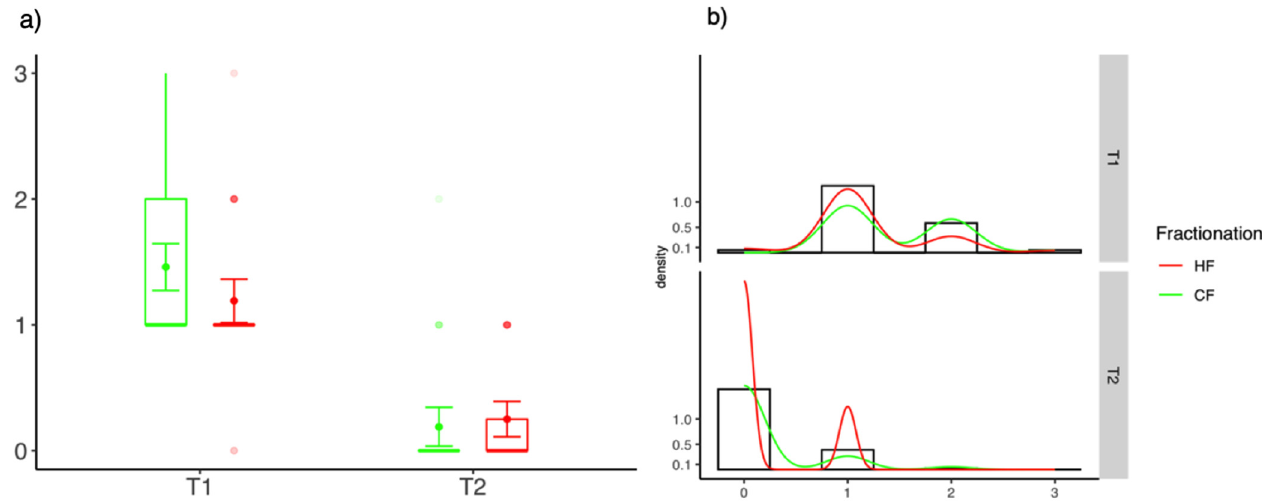
Figure 1. Differences of CTCAE scores between HF-WBI and CF-RT at the end of radiotherapy (T1) and 6 weeks after the treatment (T2). ( a ) Box-Plot diagrams and ( b ) distribution of values.